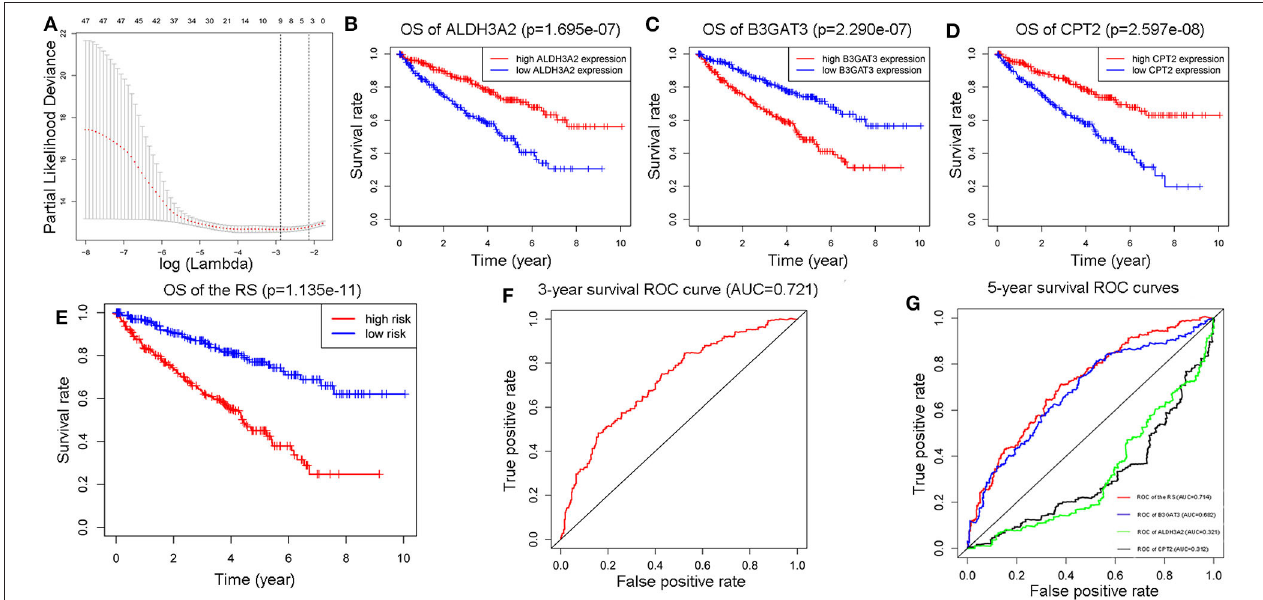
FIGURE 3 | Construction of a three-metabolic-genes RS model from 47 prognostic metabolic genes (A) . Comparison of 5-year survival K-M plots of the three genes and the RS model they composed (B–E) , a 3-year ROC curve of the RS model (F) , and 5-year ROC curves of RS model along with those three genes (G) .